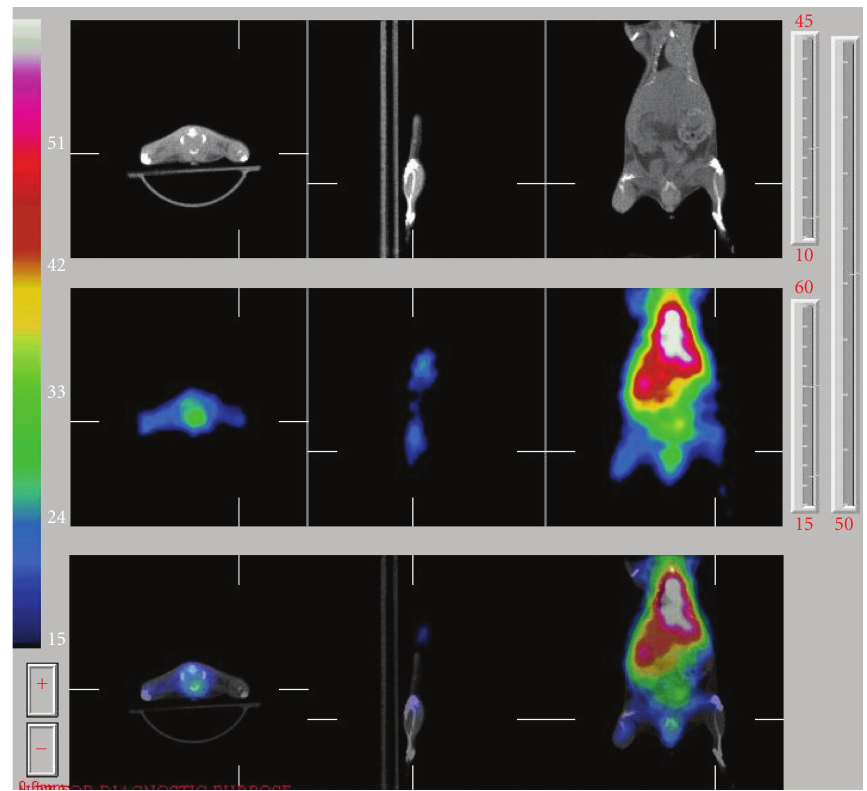
Figure 5: In vivo SPECT images of 123 I-ANV-6L15 fusion protein in an eight-week-old male BALB/c mouse. 123 I-ANV-6L15 (18.5MBq in 100 μ L physiological saline) was injected via tail vein of the mouse under isoflurane anesthesia. Whole body scan was acquired at 60–210 min after